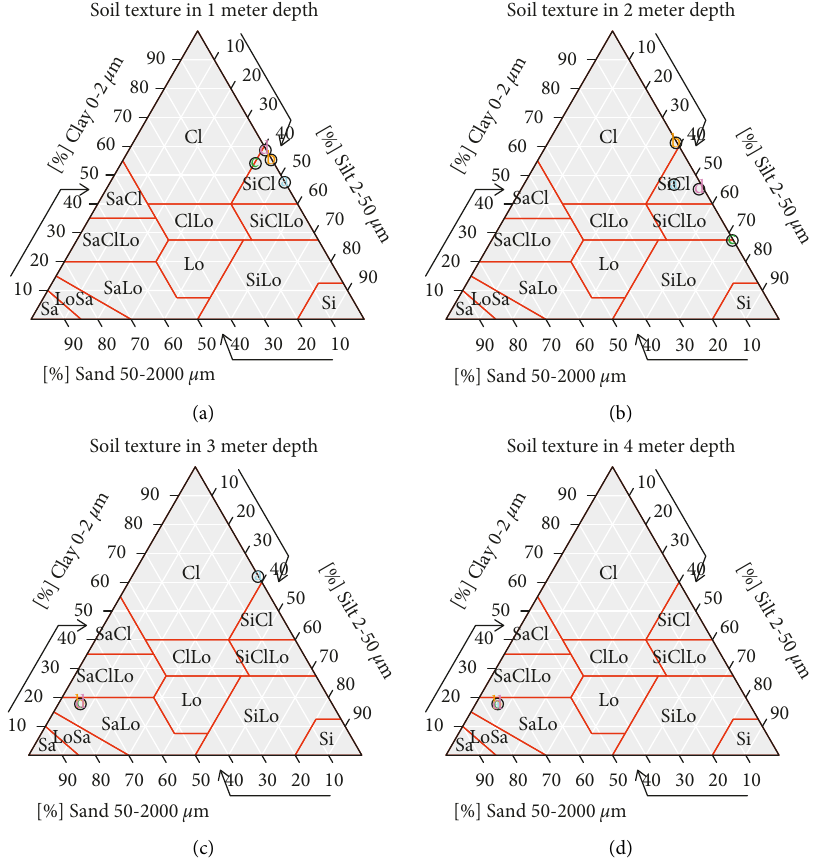
Figure 2: USDA triangle soil texture in 1 st to 4 th meters depth in the landform of Barito Delta. Soil texture in each landform indicates with color alphabet, that is, (a) with light blue color, Tidal Flat (Sample No. 3); (b) with orange color, Natural Levee (Sample No. 22); (c) with green color, Limb of Peat Anticline (Sample No. 6); (d) with violet color, Basin of Peat Anticline (Sample No.